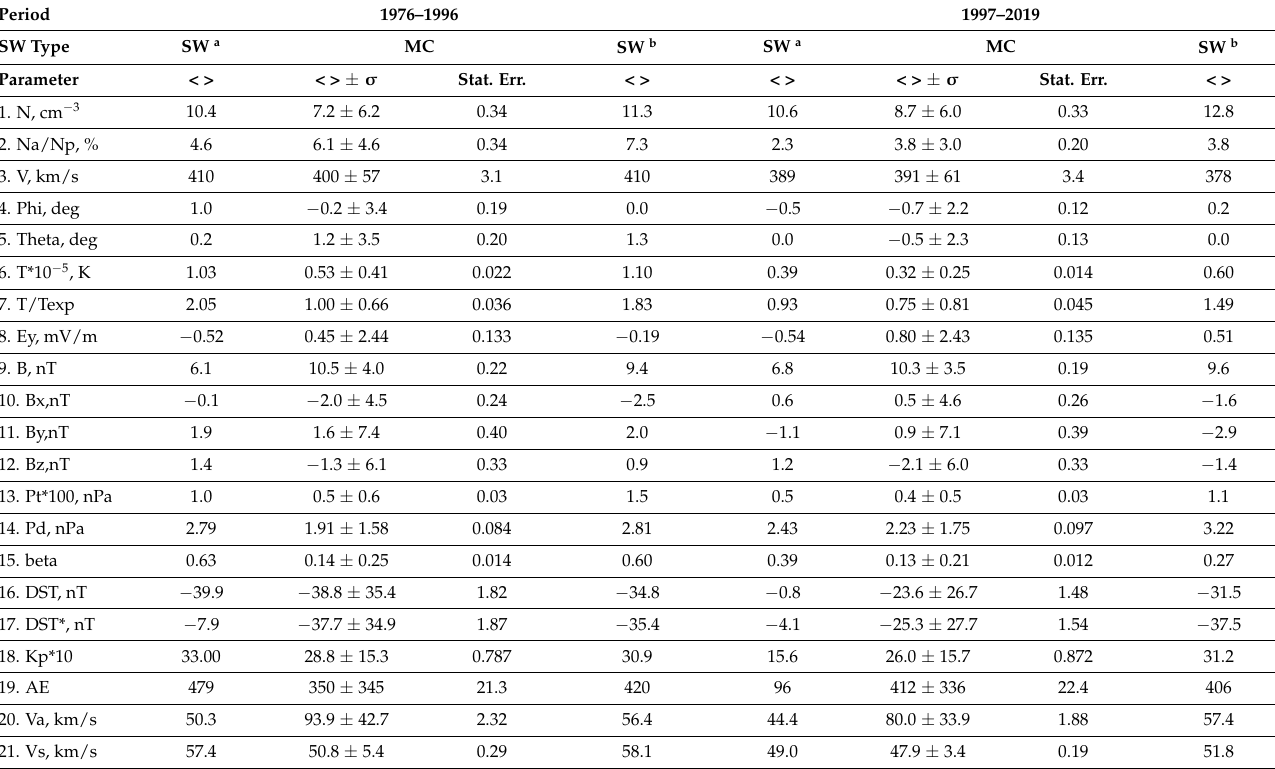
Table 6. Average parameters for sequence SW/MC/SW (Figure 6).